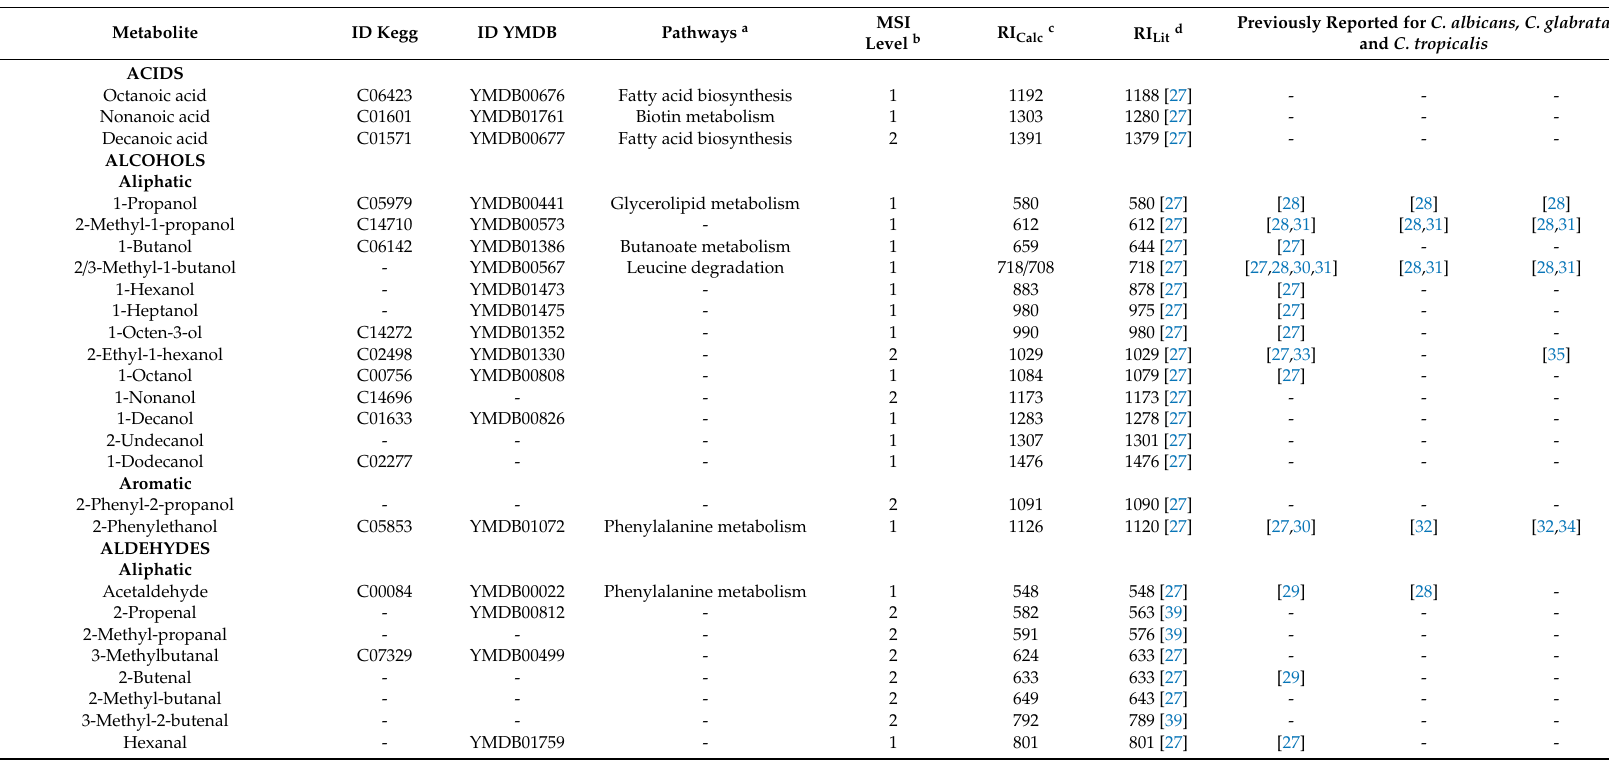
Table 1. Metabolites putatively identified in Candida species using HS-SPME / GC × GC–ToFMS. The information about ID Kegg, ID YMDB and respective pathways and the chromatographic data that helps their identification are also